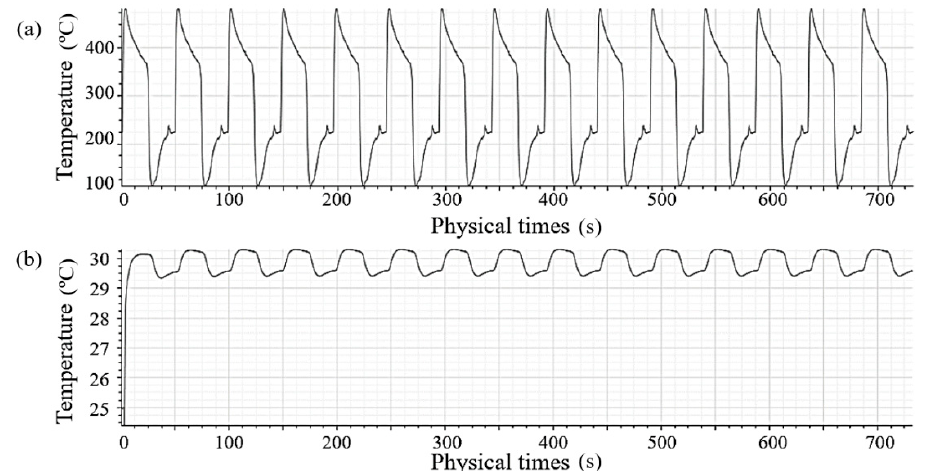
Figure 12. CFD results of the die casting process cycle through time. ( a ) Temperature convergence at the thermocouple measurement position in the die. ( b ) Temperature convergence at the coolant outlet.